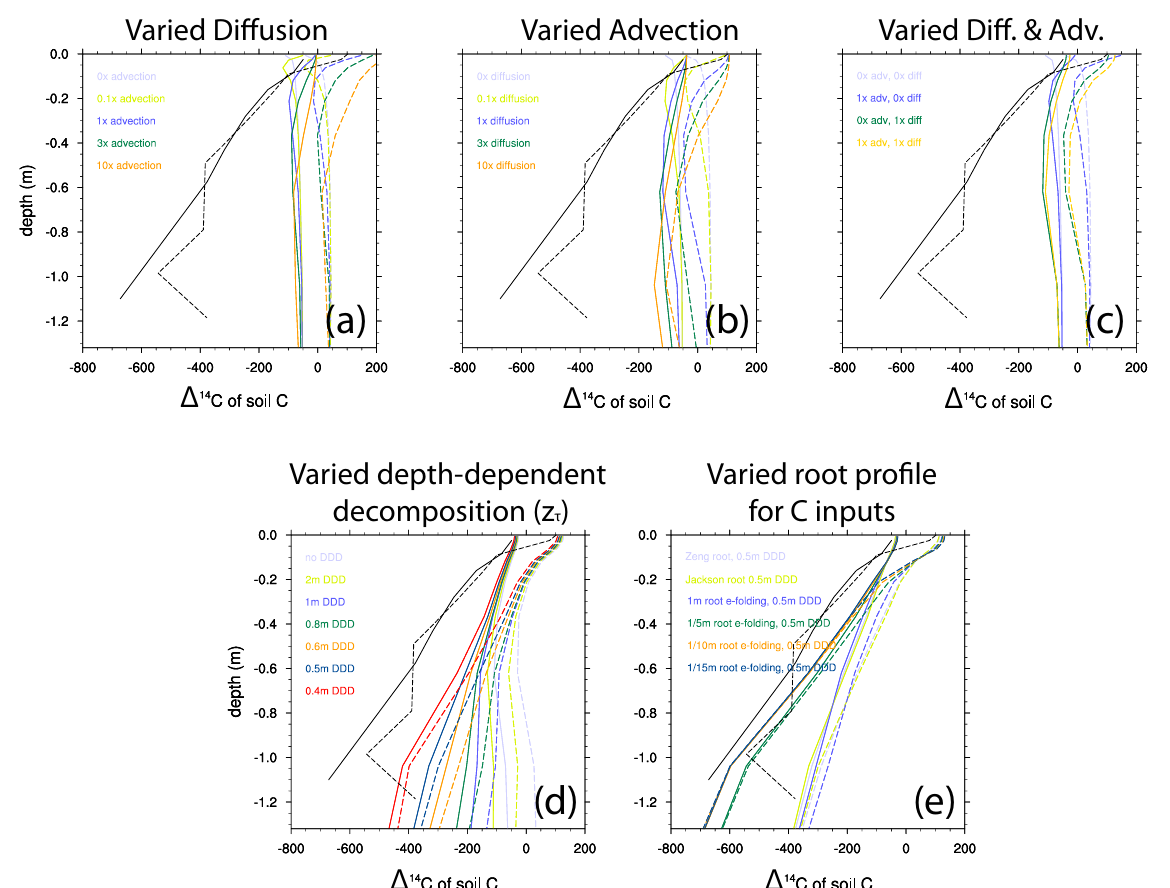
Fig. 9. Sensitivity of vertical profiles of soil 1 14 C to parameters at the Voronazh site. For all figures, solid line is archived (pre-bomb) soil 1 14 C, and dashed line is modern (1990) 1 14 C. (a–c) Response of soil 1 14 C to diffusion, advection, and combined advection plus diffusion. (d) Response of 1 14 C to depth control on soil turnover. (e) Response of 1 14 C to input profile of rooting